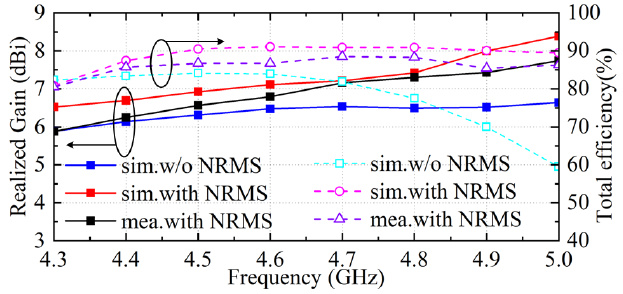
Figure 12. The total efficiency and the realized gain of the proposed antenna array.